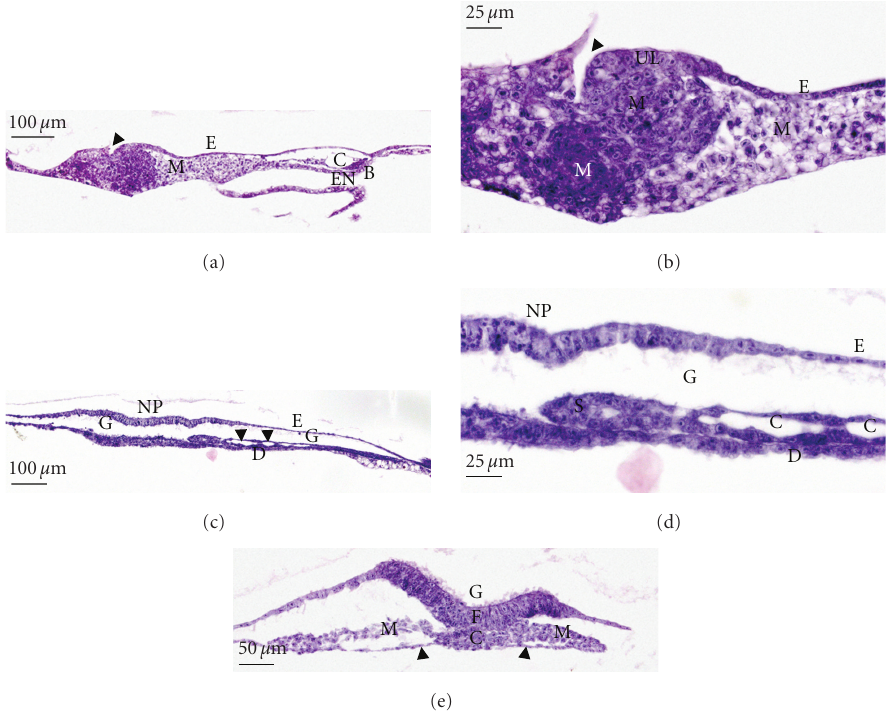
Figure 8: (a): Section through a hemiembryo after 2 days of culture. A hemi-primitive streak (with groove, indicated by arrowhead) is seen close to the cut edge; the unilateral mesoblast mantle (M) extends laterally (at the right of the figure) to form some coelomic vesicles (C) which form a dome over blood islands (B) in close association with the gut endoderm (EN). E, epiblast. Hematoxylin-eosin. Bar = 100 μ m. (b): Magnification of the medial part of Figure 8(a), showing the hemi-primitive streak region in detail. The hemi-primitive groove (arrowhead) is formed by unilateral ingrowth of thickened upper layer cells (UL) forming mesoblast strands (M) in the depth; E, epiblast (note the di ff erent aspect of the thicker undi ff erentiated upper layer and the thinner skin forming epiblast). Hematoxylin-eosin staining. Bar = 25 μ m. (c): Section through the cranial part (neural plate: NP) of a chicken hemi-embryo after 2 days of culture, at low magnification. Only a row of rudimentary coelomic vesicles (arrowheads) has developed in the unoperated side, forming the most cranial part of the coelomic cavity. Note the large intraembryonic cavity (G), empty at the operated side. No heart tube and no pericard are seen even in the unoperated side (right of the figure). Hematoxylin-eosin. Bar = 100 μ m. (d): Higher magnification of median part of the unoperated side, seen in 8C. S, somite; C, coelomic vesicles between the superficial parietopleura and the deeper splanchnopleura (forming blood islands) and adherent to the deep layer (D); bar = 25 μ m. (e): Section through the head region of a hemi-embryo after 2 days of culture, showing a neural groove (G) with median structures (derived from Hensen’s node); floor plate (F) and accompanying notochord (C), definitive endoderm (arrowheads); M, cranial mesoblast; hematoxylin-eosin. Bar = 50 μ